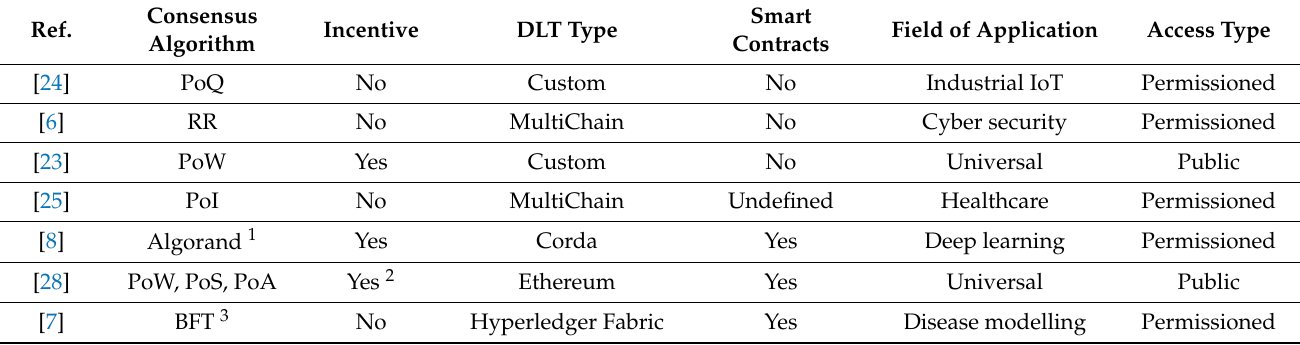
Table 1. Comparison of overviewed federated learning (FL) solutions employing blockchain. Abbreviations: PoQ: Proof of Training Quality; RR: Round-robin-based; PoW: Proof-of-Work; PoI: Proof-of-Information; PoS: Proof-of-Stake; PoA: Proof-of-Authority; BFT: Byzantine Fault